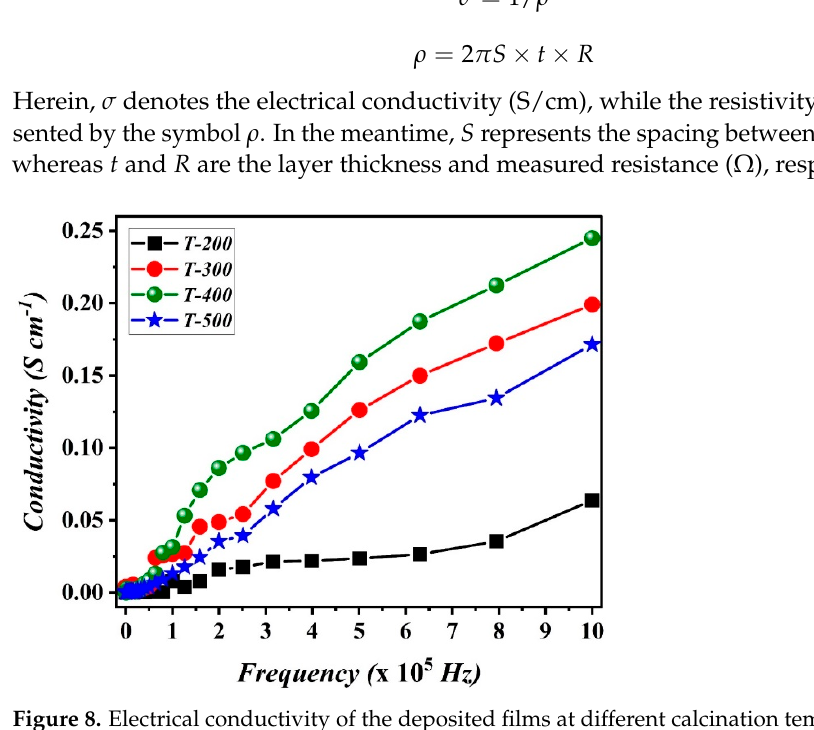
Figure 8. Electrical conductivity of the deposited films at different calcination temperatures. Table 1. In-depth electrical characteristics of the fabricated MMO films.